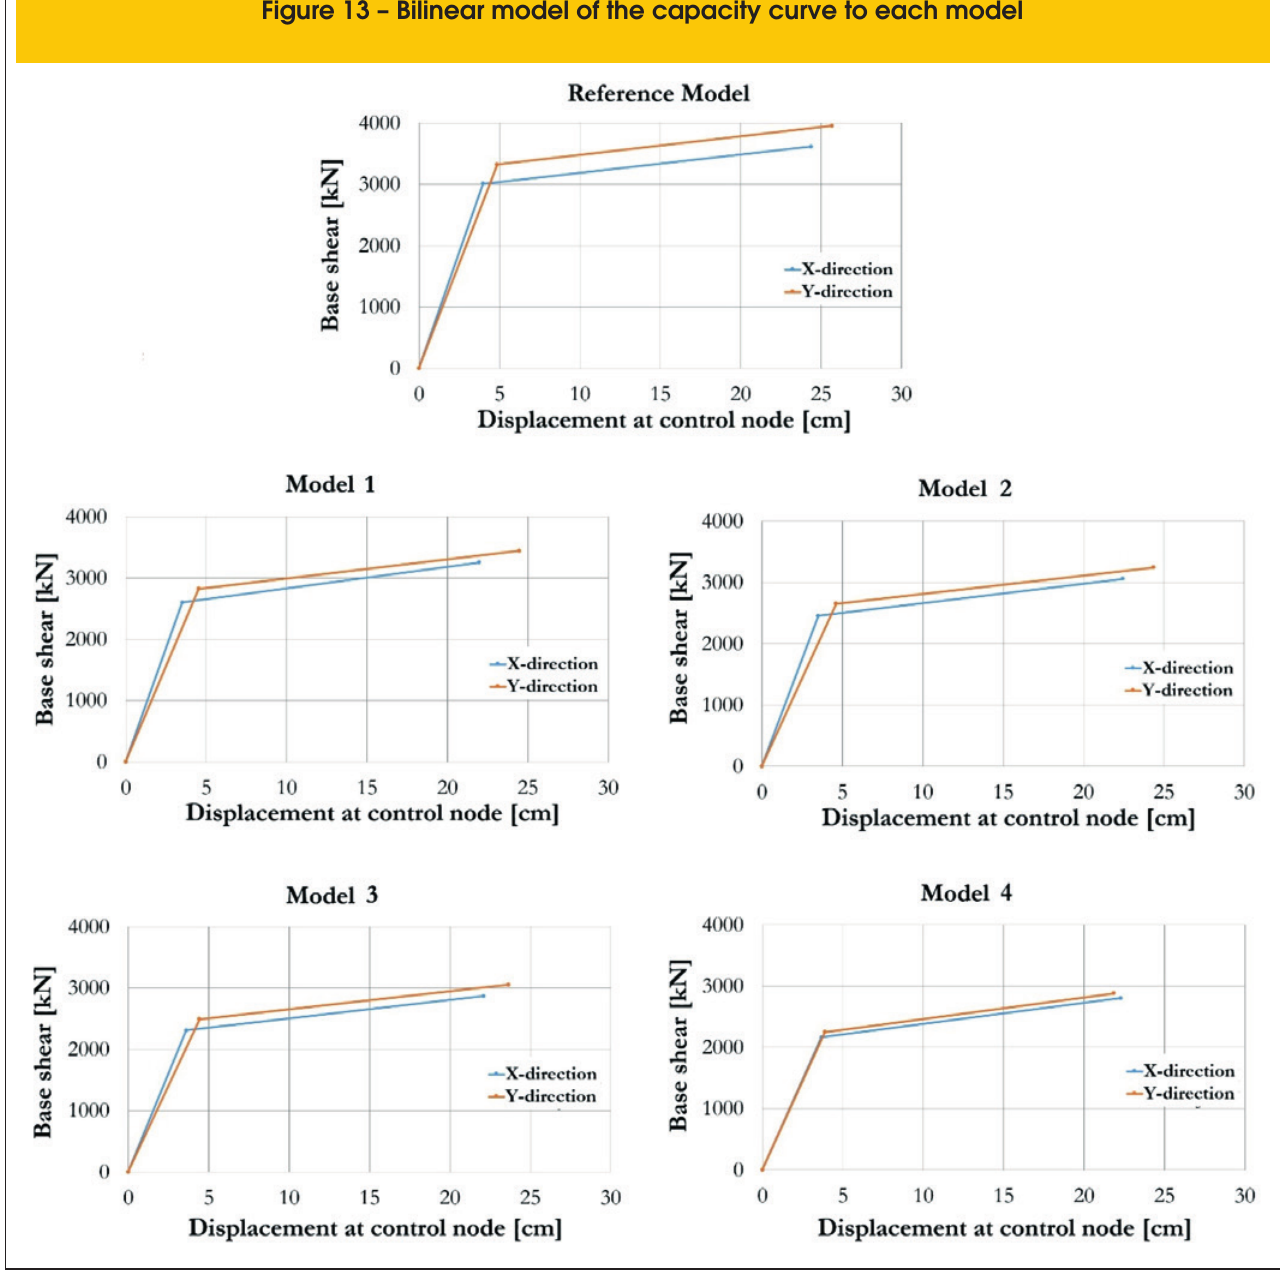
Figure 13 – Bilinear model of the capacity curve to each model